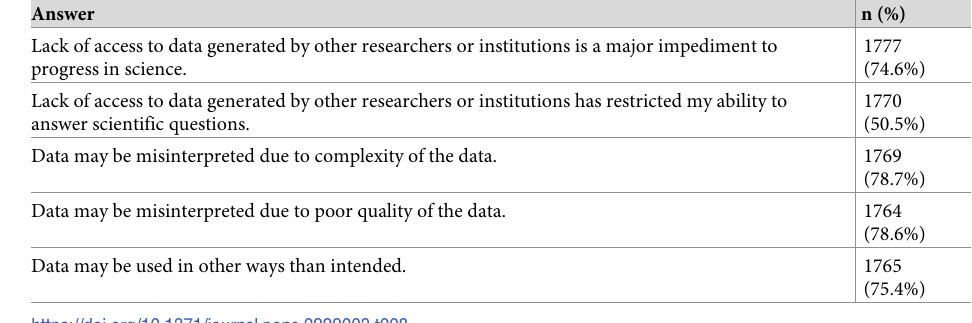
Table 8. “The following statements relate to your views on the use of scientific research data. Tell us how much you agree with each statement”.